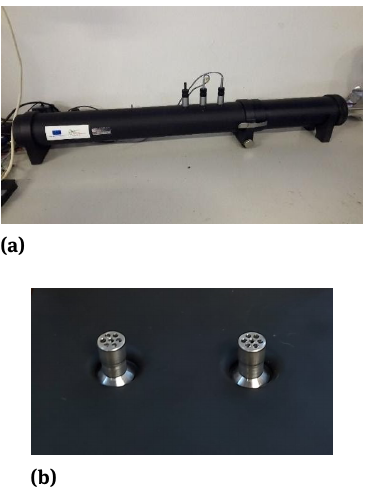
Figure 4: Kundt tube (a); Microphones (b)